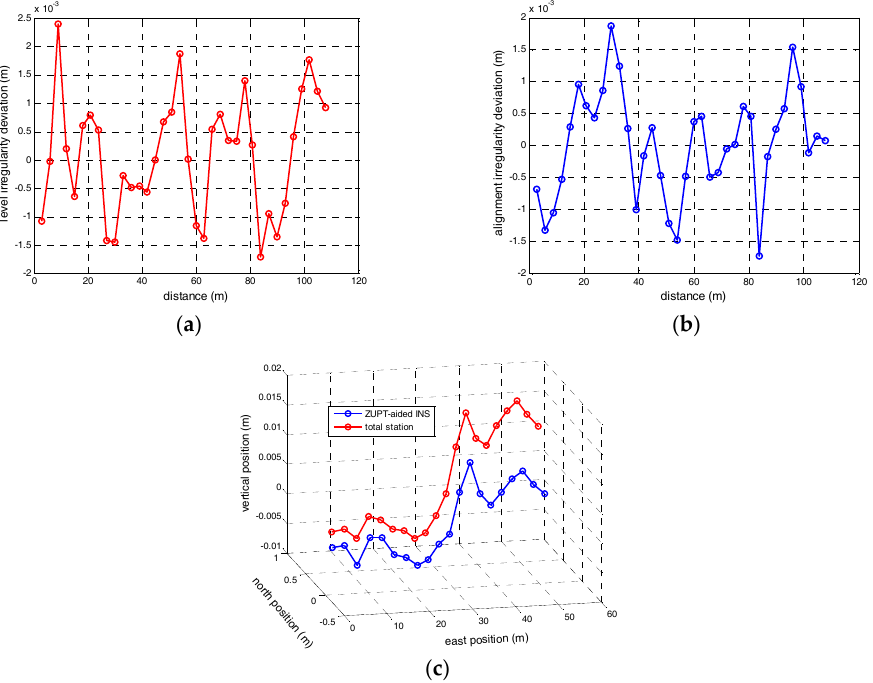
Figure 14. ( a ) Level irregularity deviation for 30 m chord between ZUPT-aided INS and total station; ( b ) Alignment irregularity deviation for 30 m chord between ZUPT-aided INS and total station; ( c ) 3D spatial trajectory of 60 m track segmentation measured by ZUPT-aided INS and total